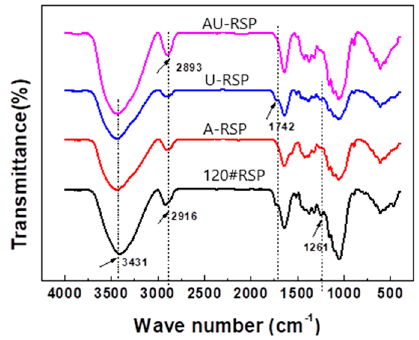
Figure 4. FTIR spectra of RSP before and after pretreatment.